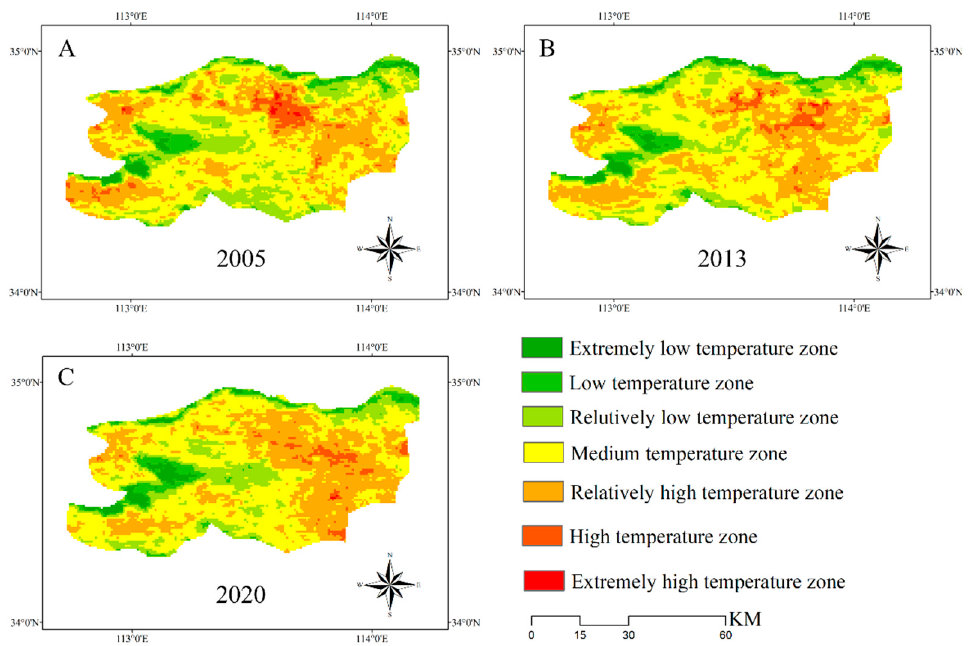
Figure 4. Spatial evolution of UHI in Zhengzhou in 2005, 2013, and 2020: ( A ) 2005, ( B ) 2013, ( C )